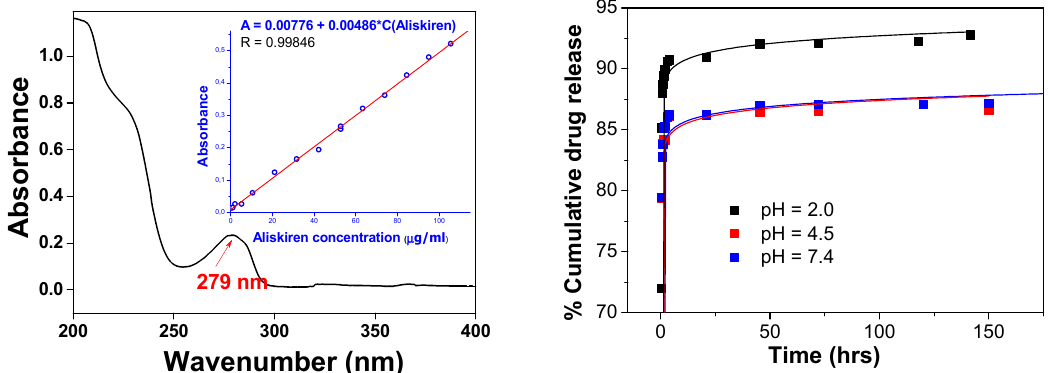
Figure 3. UV/vis spectrum of aliskiren ( left ) and calibration curve of pure aliskiren (inset). Time dependence drug release from NP ALIS at 37 °C and at different pH ( right ).